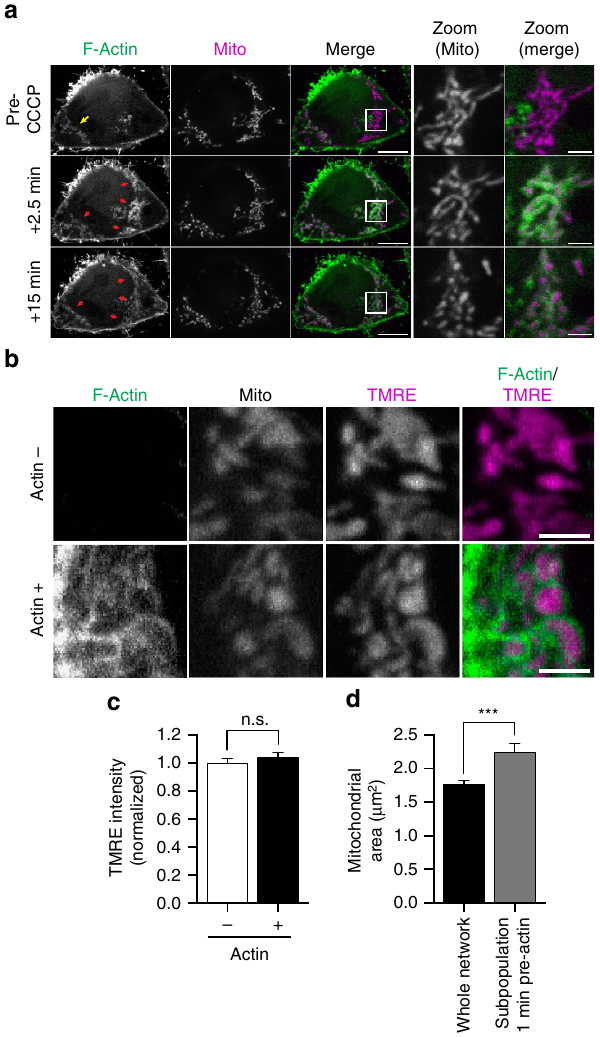
Figure 3 | Actin cycles onto polarized and elongated mitochondria in healthy cells. ( a ) Time series demonstrating stable recruitment of F-actin (LifeAct-GFP) to mitochondria (Mito-DsRed2) in HeLa cells depolarized by treatment with 20 m M CCCP. Before CCCP treatment, cycling actin can be visualized on a subpopulation of HeLa cell mitochondria (yellow arrow, top panel). Within 2.5min of CCCP treatment, actin was stabilized on 4 90% of all mitochondria (red arrows) and robust fission of all mitochondria was observed by 15min post CCCP treatment. ( b , c ) Untreated cells expressing LifeAct-GFP and Mito-BFP display no significant difference in TMRE intensity between actin-positive and actin-negative mitochondria. ( d ) One minute before actin recruitment, mitochondria targeted for actin assembly are significantly larger than average mitochondria within the cell. Values represent means ± s.e.m. *** P o 0.001; NS, not significant. Scale bars, 10 m m ( a full size); 2.5 m m ( a zoom, b ). Sample size: ( c ) 50 mitochondria from 10 cells per condition; ( d , whole network) 27 cells; ( d , actin-targeted subpopulation) 26 cells; n Z 3 independent experiments in all